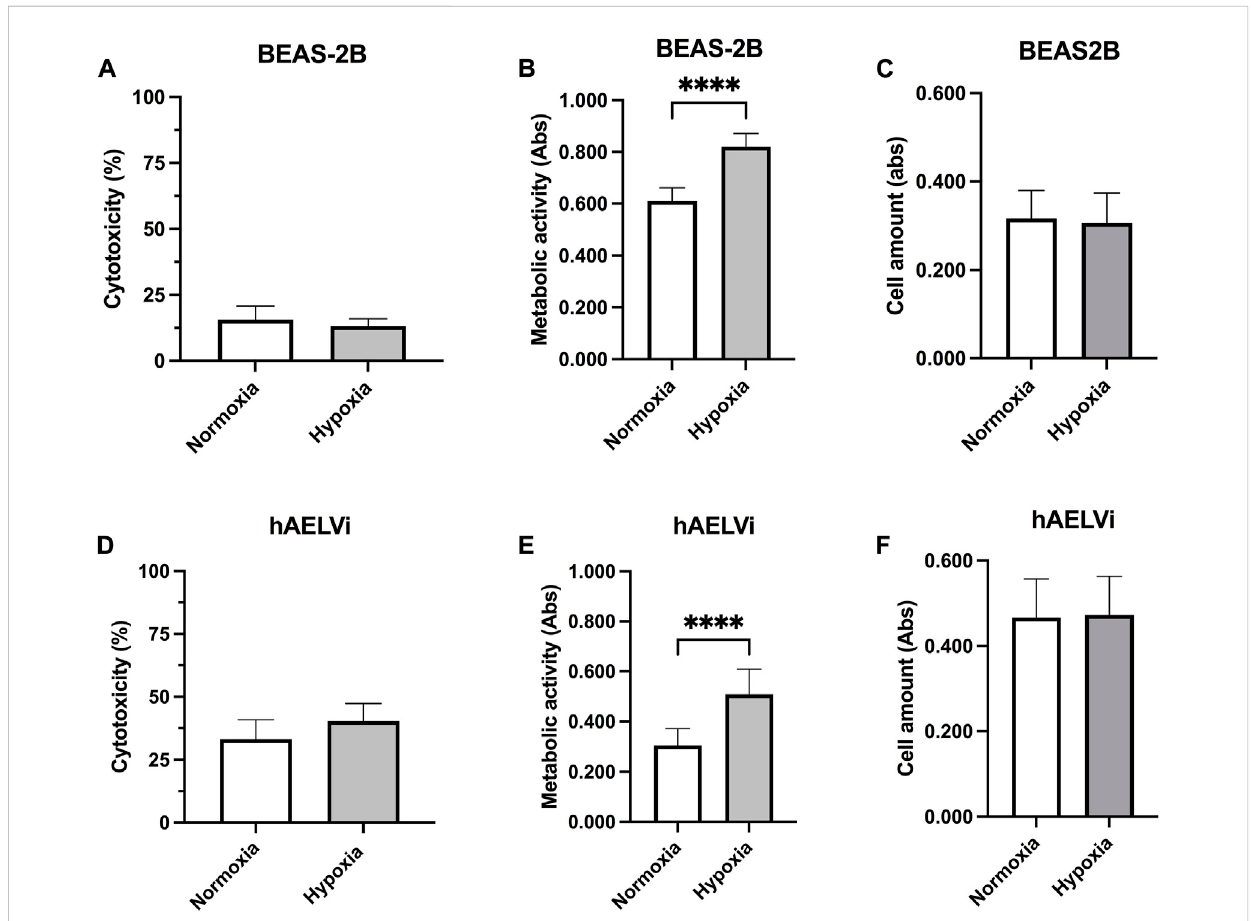
FIGURE 6 Cell viability after hypoxia exposure. Cytotoxicity measurements of BEAS-2B (A) and hAELVi (D) after 24 h exposure to either normoxia or hypoxia. Samples were related to cells treated with 1% Triton X-100, set to 100% cytotoxicity. Measured metabolic activity in BEAS-2B (B) and hAELVi (E) cells exposed to normoxia or hypoxia for 24 h. Cell amount in BEAS-2B (C) and hAELVi (F) after 24 h exposure to either normoxia or hypoxia. Data is based on 2-3 individual experiments with biological replicates ( n = 6 – 8) for BEAS-2B and ( n = 11 – 13) for hAELVi. Data is presented as mean ± SD.